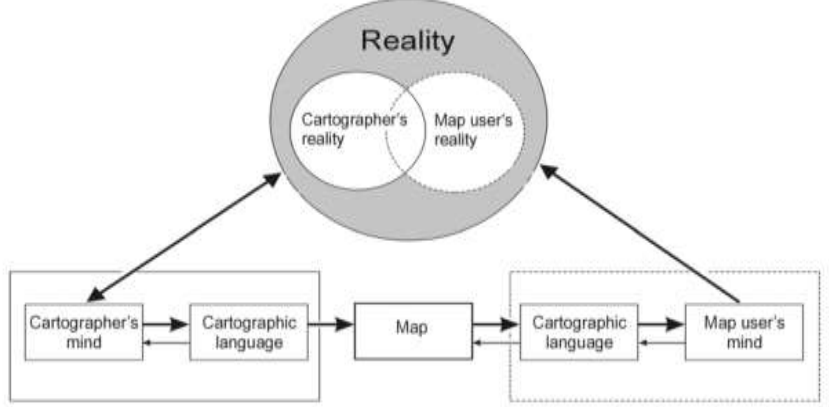
Fig. 1 The cartographic information transmission model proposed by Kolacny